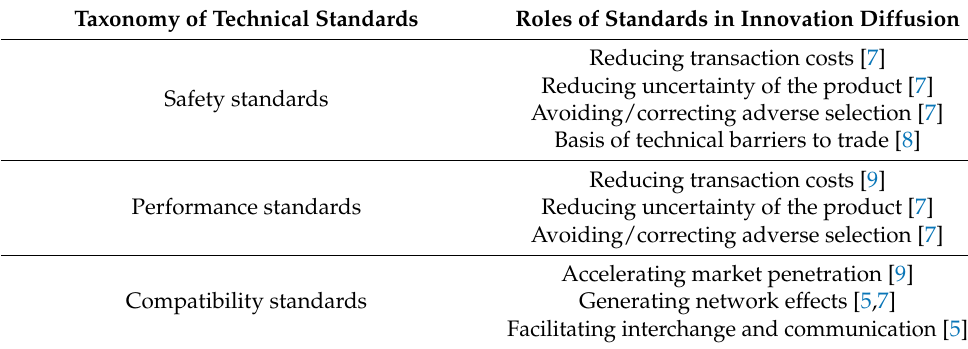
Table 1. The roles of different functions of technical standards as related to innovation diffusion, based on the literature